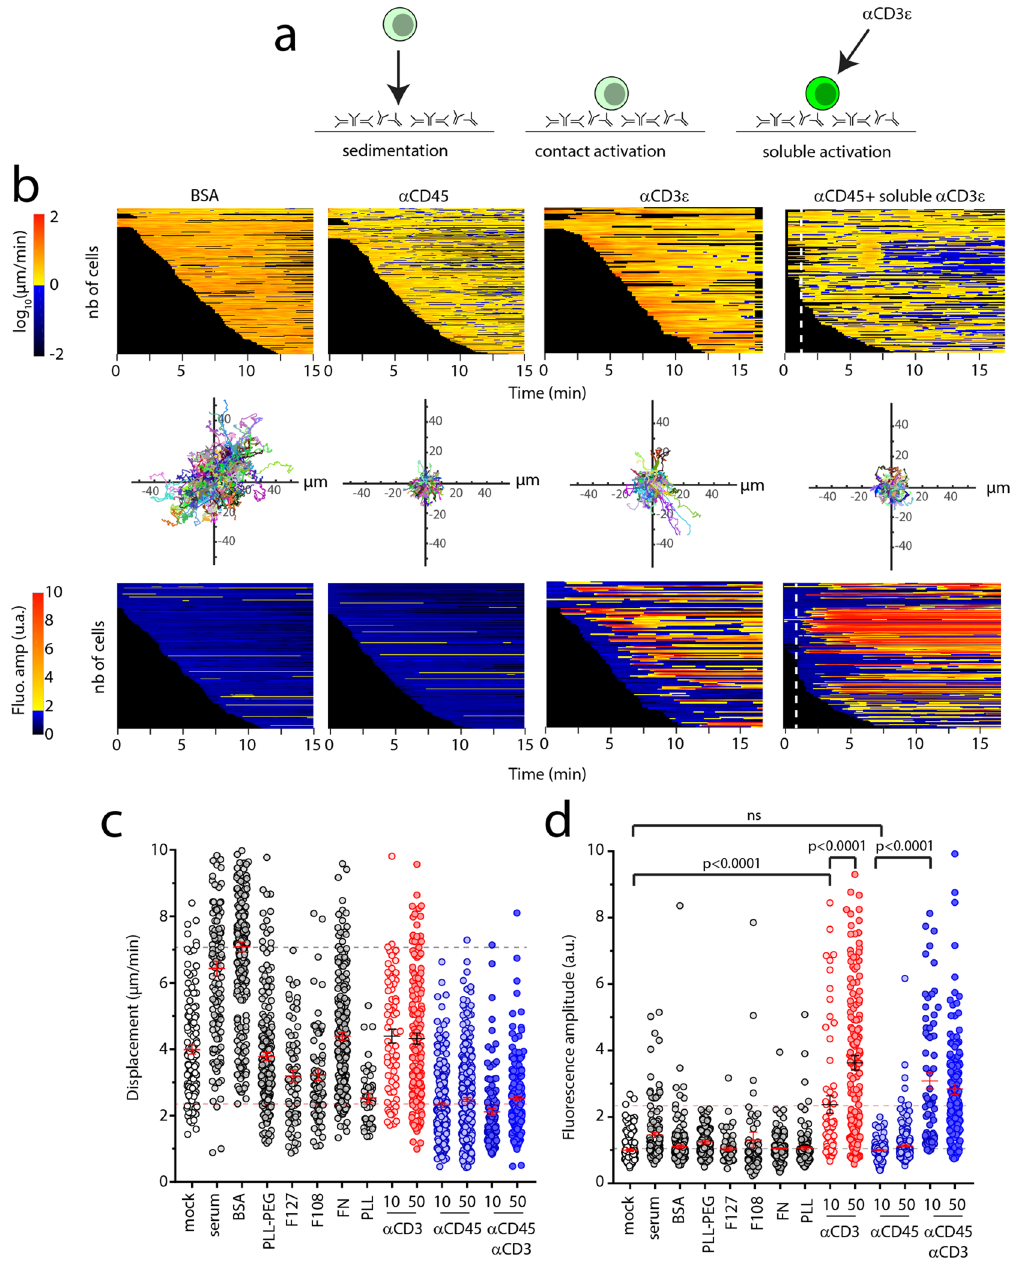
Figure 1. ( a ). Schematics of a MAAACS 42 experiment, where cells first sediment on a substrate which may be passivated, adherent or activating and were, in some cases, further stimulated with soluble anti CD3 antibodies. ( b ) Heatmaps of cell displacement, re-aligned cellular trajectories (over the duration of the acquisition, typically 15 or 30 min) and heatmaps of normalized calcium fluxes vs. time extracted from representative movies on (i) a non adhesive substrate (BSA 1%), (ii) an adhesive but non activating substrate (anti CD45 antibody), (iii) an adhesive and activating substrate (anti CD3 antibody), and (iv) on cells after landing on (ii), but subjected to reactivation via soluble anti CD3 antibody (the instant of injection is presented as a dotted line). One line corresponds to one detected cell. ( c ) Measured displacement of cells, from MAAACS (see text), which is used to define the adhesiveness of the tested substrates: when average displacement is < 3 µm/min, the substrate is defined as adhesive. Dotted lines were shown for min and max mean values. ( d ) Fluorescence amplitude of cells, corresponding to substrates tested in c . Dotted lines were shown for min and anti CD3 mean values. Mock condition corresponds to non treated, bare glass. Data was presented as scatter plots (1 point per cell) with mean ± SEM. Significance of difference was assessed with Mann–Whitney